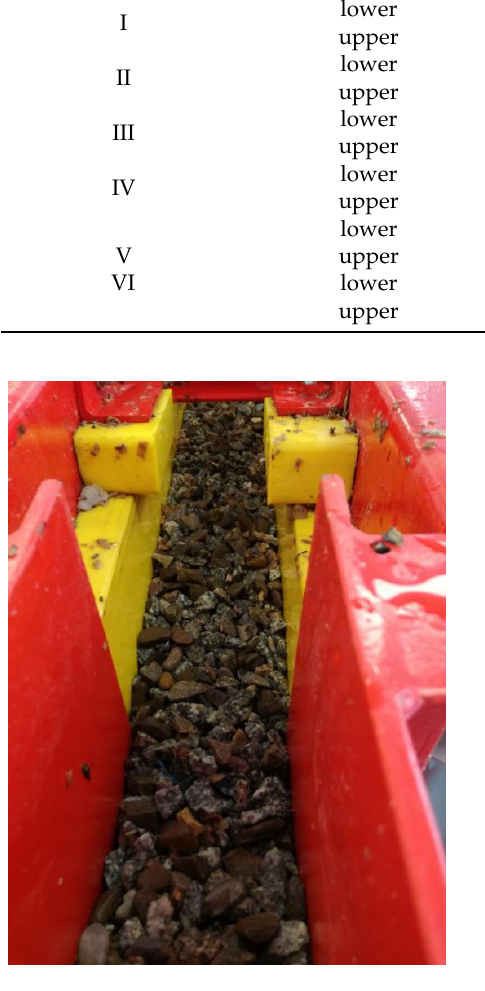
Figure 9. Upper layer in the SET separator for the test with irregular particles.